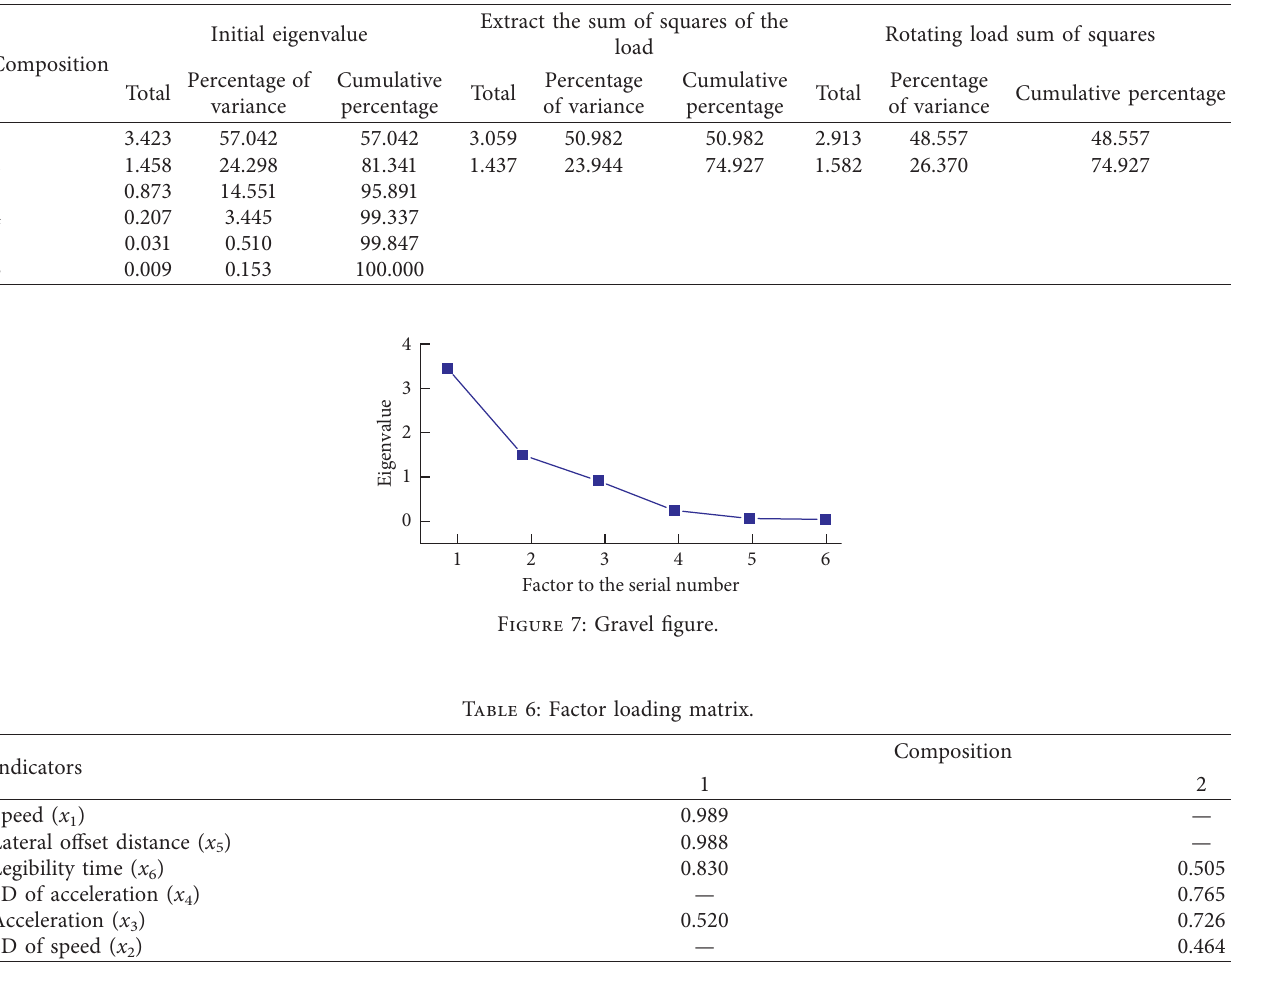
Table 5: Total variance interpretation.